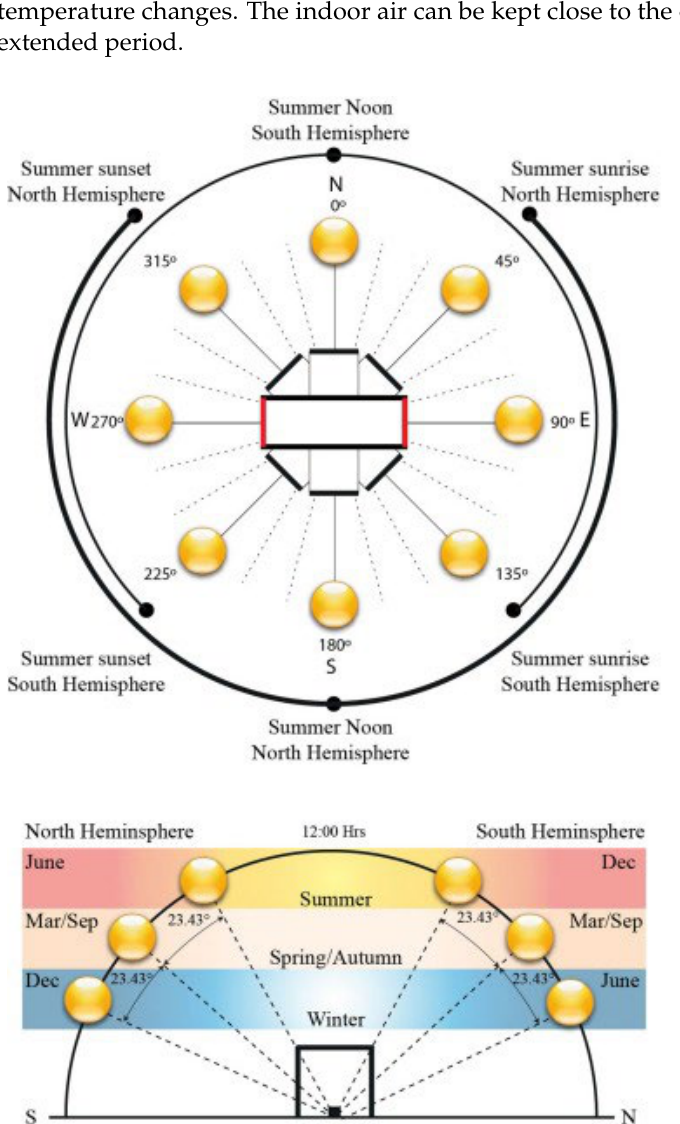
Figure 6. Schematic plan and section of an isometric rectangular building in the path of the summer sun [55]. sun